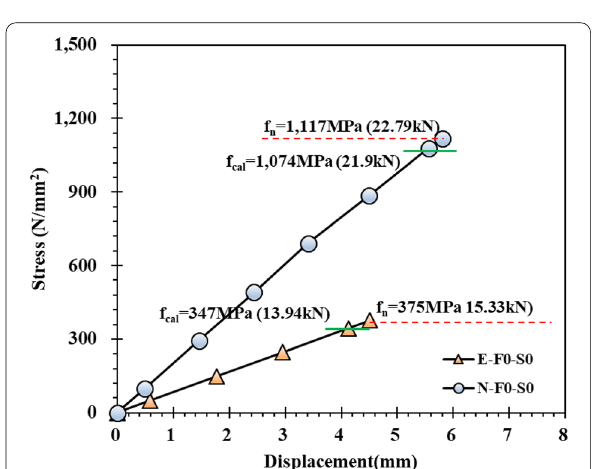
Fig. 10 Stress–displacement curves of FRPs bonded to concrete under normal temperature (22–24